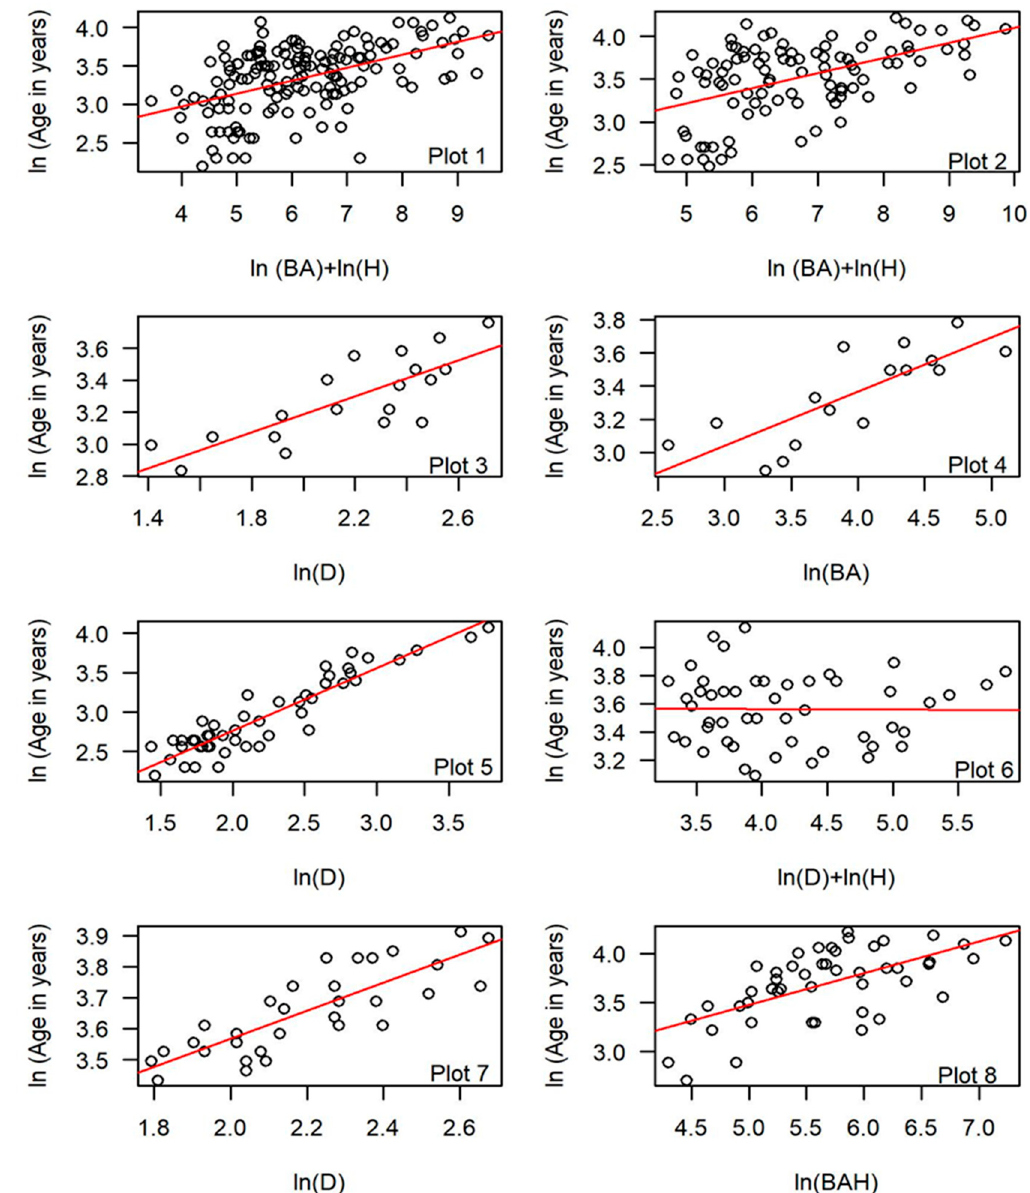
Figure 9. Scatter plots of the allometric equations used to predict L. azorica (Seub.) Franco age from dendrometric traits (BA, Basal Area; D, Diameter at Breast Heigth; H, Maximun Tree Height) Comparison of models for all the available samples at breast height, ( plot 1 , as defined in Table 2), at tree base ( plot 2 , as defined in Table 2) and for each stand ( plots 3 – 8 , as defined in Table 2). This is a selection of the best models. See Table 2 and Tables S1–S7 for the full set of tested models.